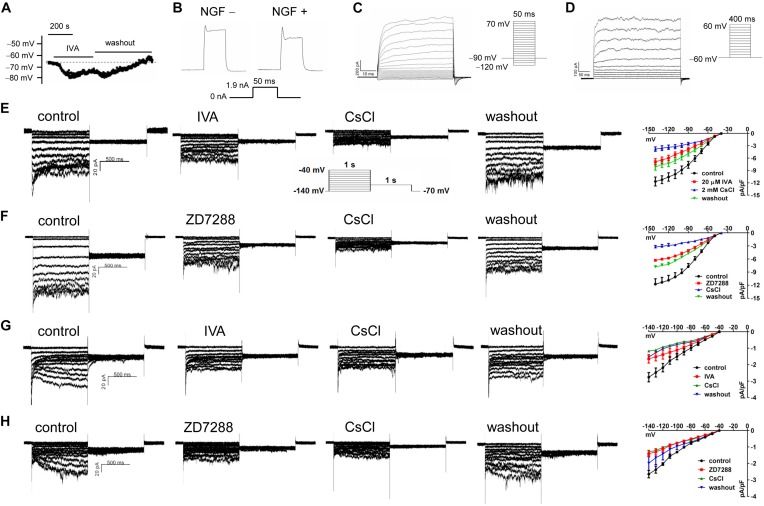
The transmembrane potentials and channel currents of PC12 cells with or without NGF treatment. (A) Resting potential (RP) recorded at a current-clamping mode in NGF-pretreated PC12 cells, note that blocking HCN channels with IVA (10 μmol/l) hyperpolarized the RP. (B) Suspicious action potentials evoked by electric pulses in NGF-untreated and NGF-treated PC12 cells (recorded at a current-clamping mode). Note that cells showed regular depolarization but immature repolarization potentially because of the large outward rectification. NGF treatment likely improved the repolarization. (C) Macrocurrents elicited by a stimulating protocol for activating voltage-gated Na+ channel in the absence of any channel blocker. No inward (supposing Na+) current was recorded, suggesting that PC12 cells did not develop mature voltage-gated Na+ channel even treated with NGF for certain time. (D) Macrocurrents recorded using a stimulating protocol for activating K+ channels in the absence of any channel blocker. Outward (K+) currents were recorded. (E,F) HCN channel currents recorded in NGF-untreated PC12 cells at a voltage clamping mode. The currents were blocked or partially blocked by IVA (E), CsCl (E,F), and ZD7288 (F). (G,H) HCN currents recorded in NGF-treated PC12 cells. Note that the HCN currents were obviously smaller than that in NGF-untreated PC12 cells. Again, the currents were blocked or partially blocked by IVA, CsCl and ZD7288. The far right subpanels in panels (E–H) are the respective I–V curves which reflect the HCN current densities at different clamping voltage.